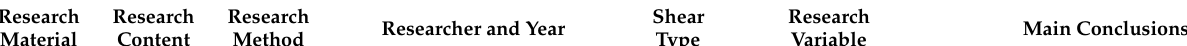
Table 1. Previous research on mechanical properties of coral sand based on triaxial shear